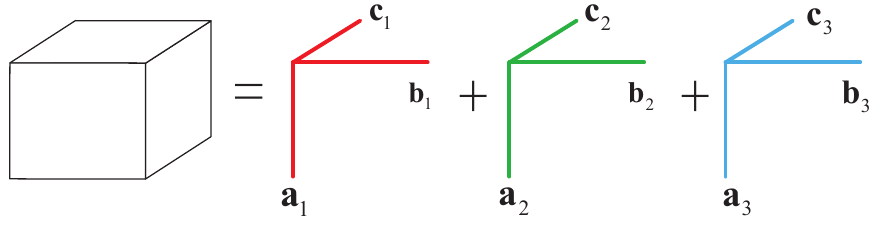
Figure 1. Illustration of a rank 3